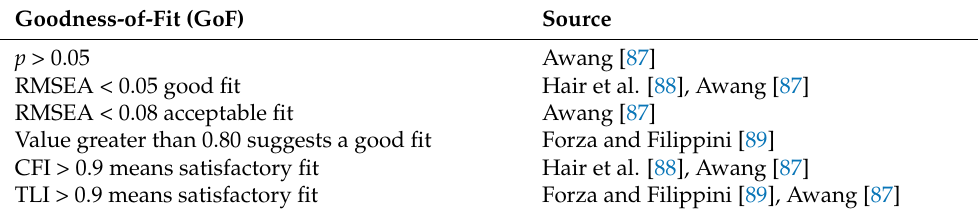
Table 7. Assessment of the goodness-of-fit ( GoF